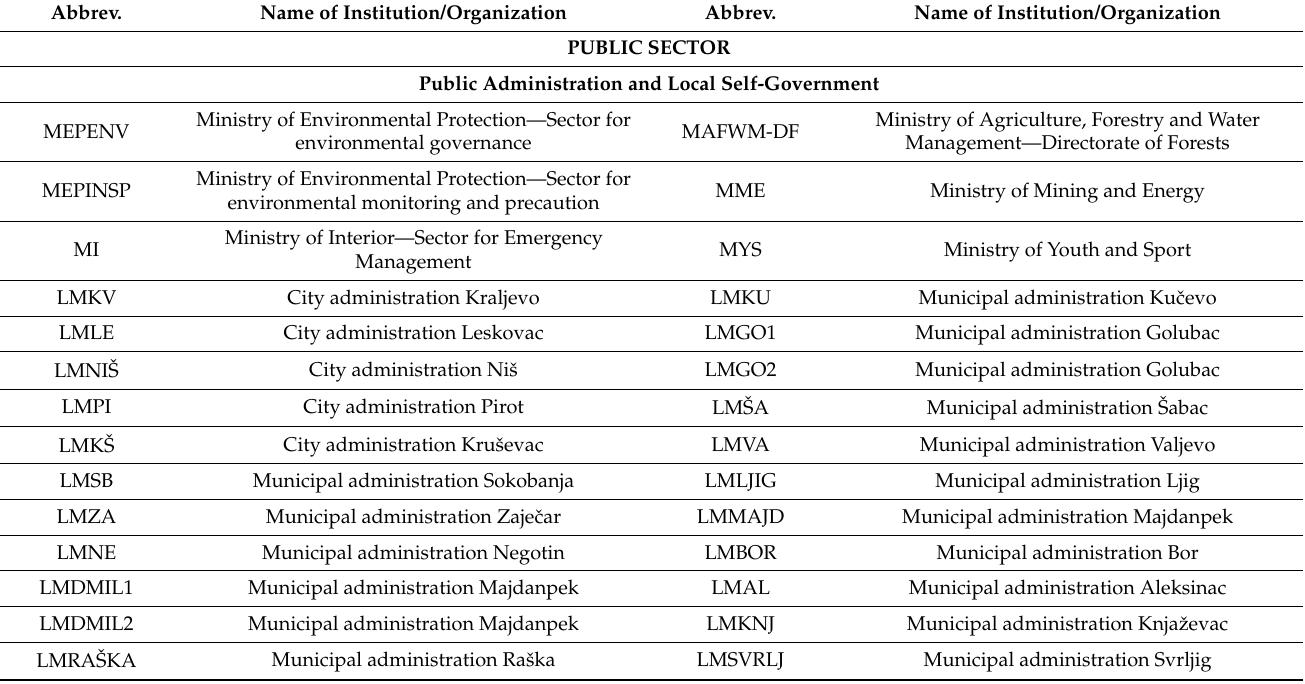
Table A3. Overview of public sector stakeholders in collaboration network per sector affiliation.